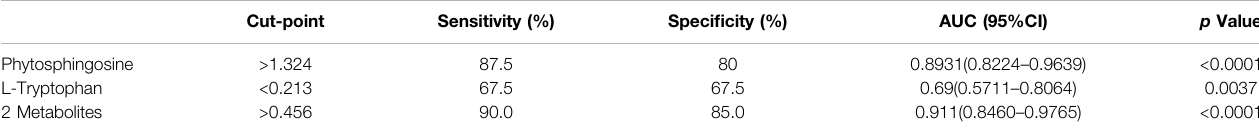
TABLE 6 | The diagnosis value of the overlapping metabolite biomarkers.